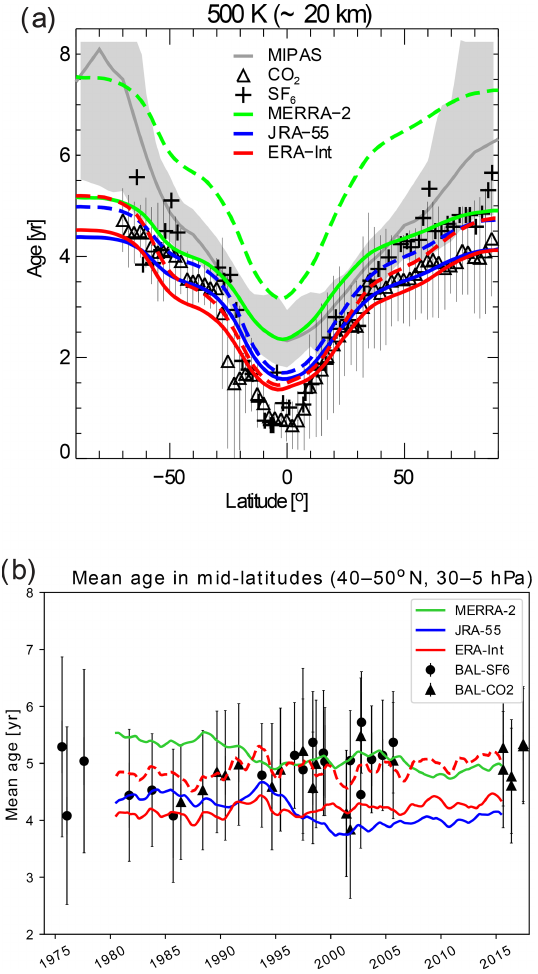
Figure 11. (a) Latitude section of mean age at 20km from in situ observations (e.g. Waugh, 2009) shown using black symbols, from different reanalysis data sets at 500K potential temperature (red represents ERA-Interim, blue represents JRA-55 and green repre- sents MERRA-2) and from MIPAS satellite observations (grey). Dashed lines show the reanalysis mean age including the correc- tion for the finite age spectrum tail (see text). Grey shading shows the range between maximum and minimum MIPAS observations at each latitude. (b) Mean age time series in the northern mid- dle latitudes (40–50 ◦ N and 30–5hPa, 600–1200K for reanalyses). Coloured lines show the mean age from the different reanalyses (red dashed line denoted the corrected mean age for ERA-Interim). Black symbols show the mean age from the balloon observations of Engel et al. (2017), with error bars representing the uncertainty of the observations.